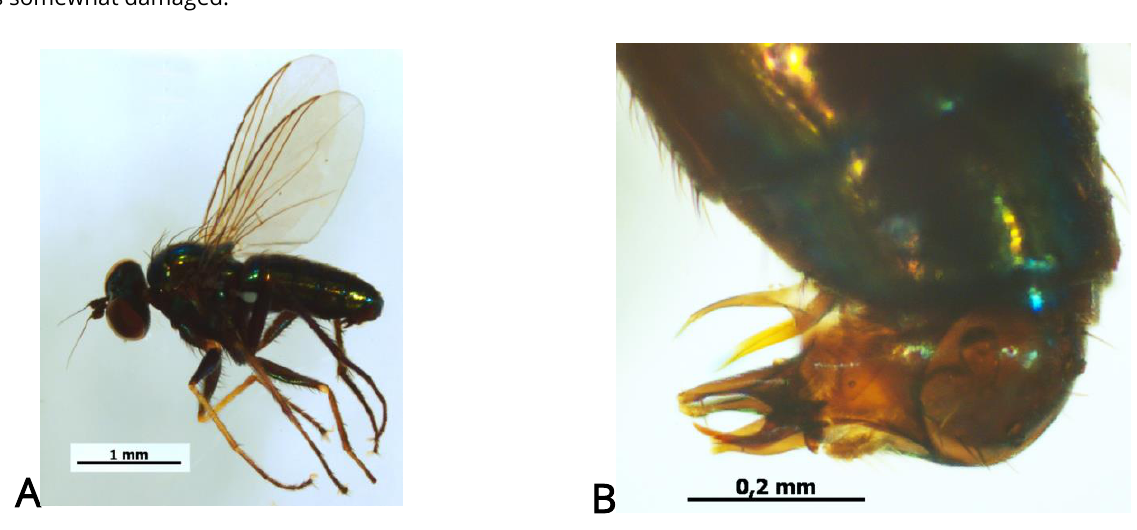
Figs. 3. Asyndetus albifrons Loew, 1869: A-male habitus;